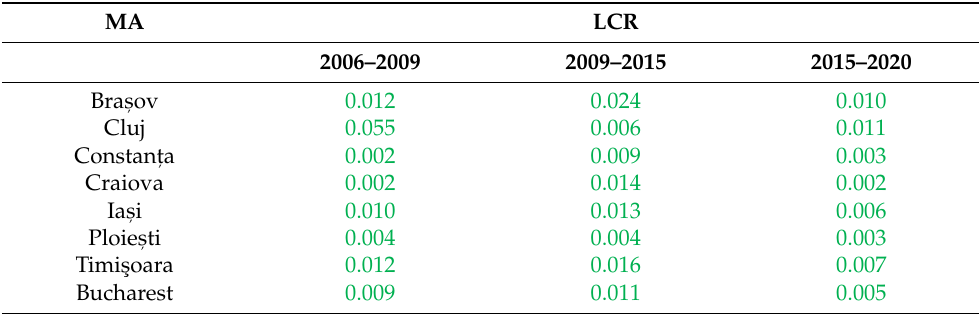
Table 4. Temporal variability of the LCR values at metropolitan area (MA) level (low 0–0.1,